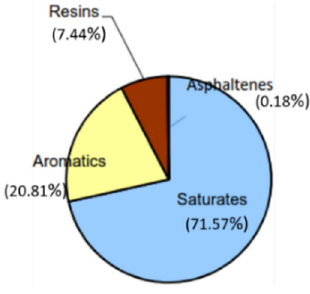
Figure 1. Saturates, aromatics, resins, and asphaltenes (SARA) analysis (wt.%) for crude